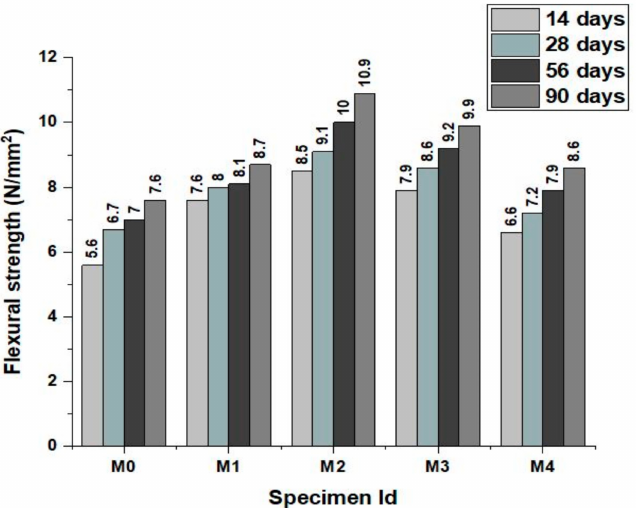
Figure 6. Flexural strength of the concrete mixes at various